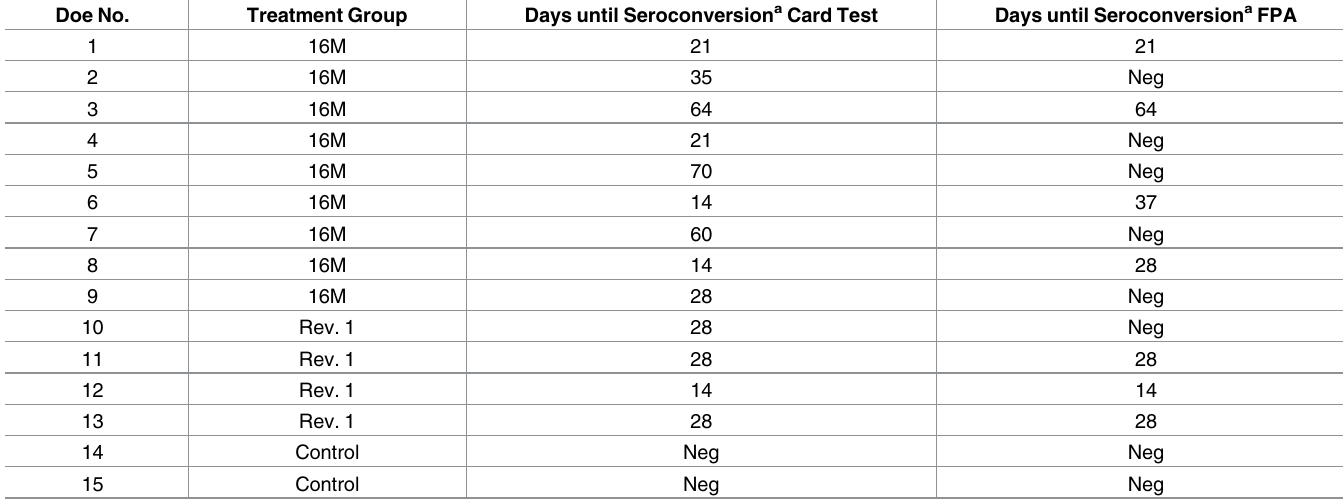
Table 4. Time to seroconversion in B . melitensis 16M- and Rev. 1-infected does determined by Card Test and FPA. Doe